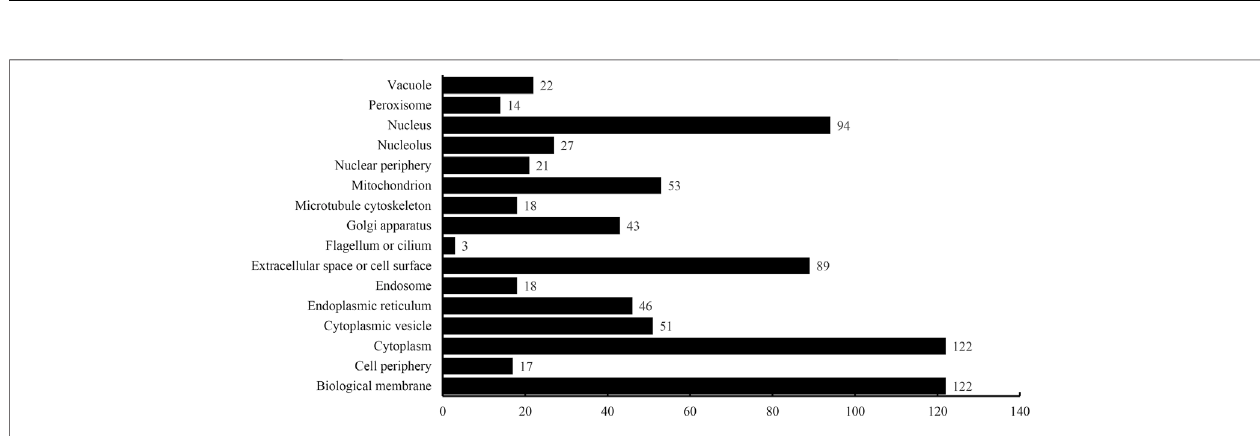
FIGURE 5 | Number of quantitative rules for each of 16